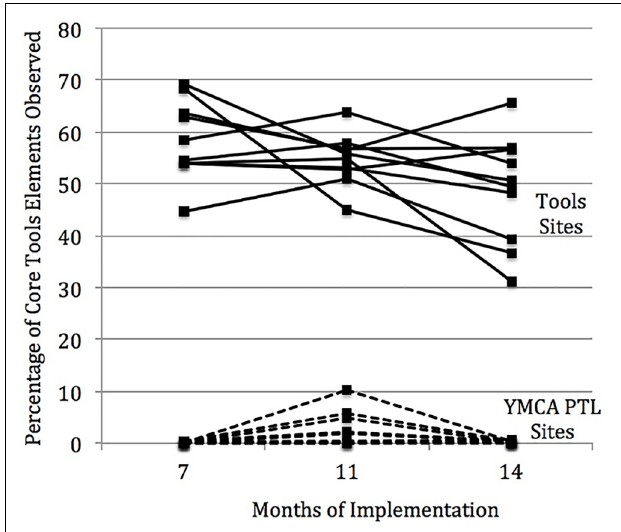
FIGURE 2 | Implementation fidelity of the Tools curriculum. The percentage of core Tools elements observed at each time point are shown for individual sites. Only the teachers in the Tools group implemented Tools and they did so with moderate success. As expected with any new initiative, there was cross-site variability in the degree of Tools implementation